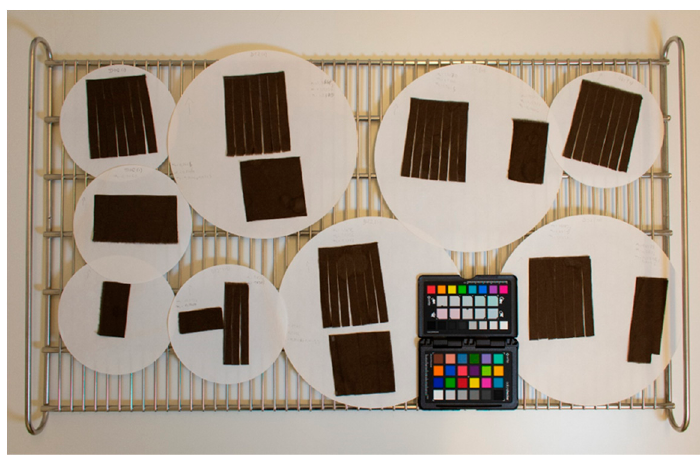
Figure 2. Cotton samples coloured with iron-tannate dyes, prepared for artificial ageing and tensile testing.